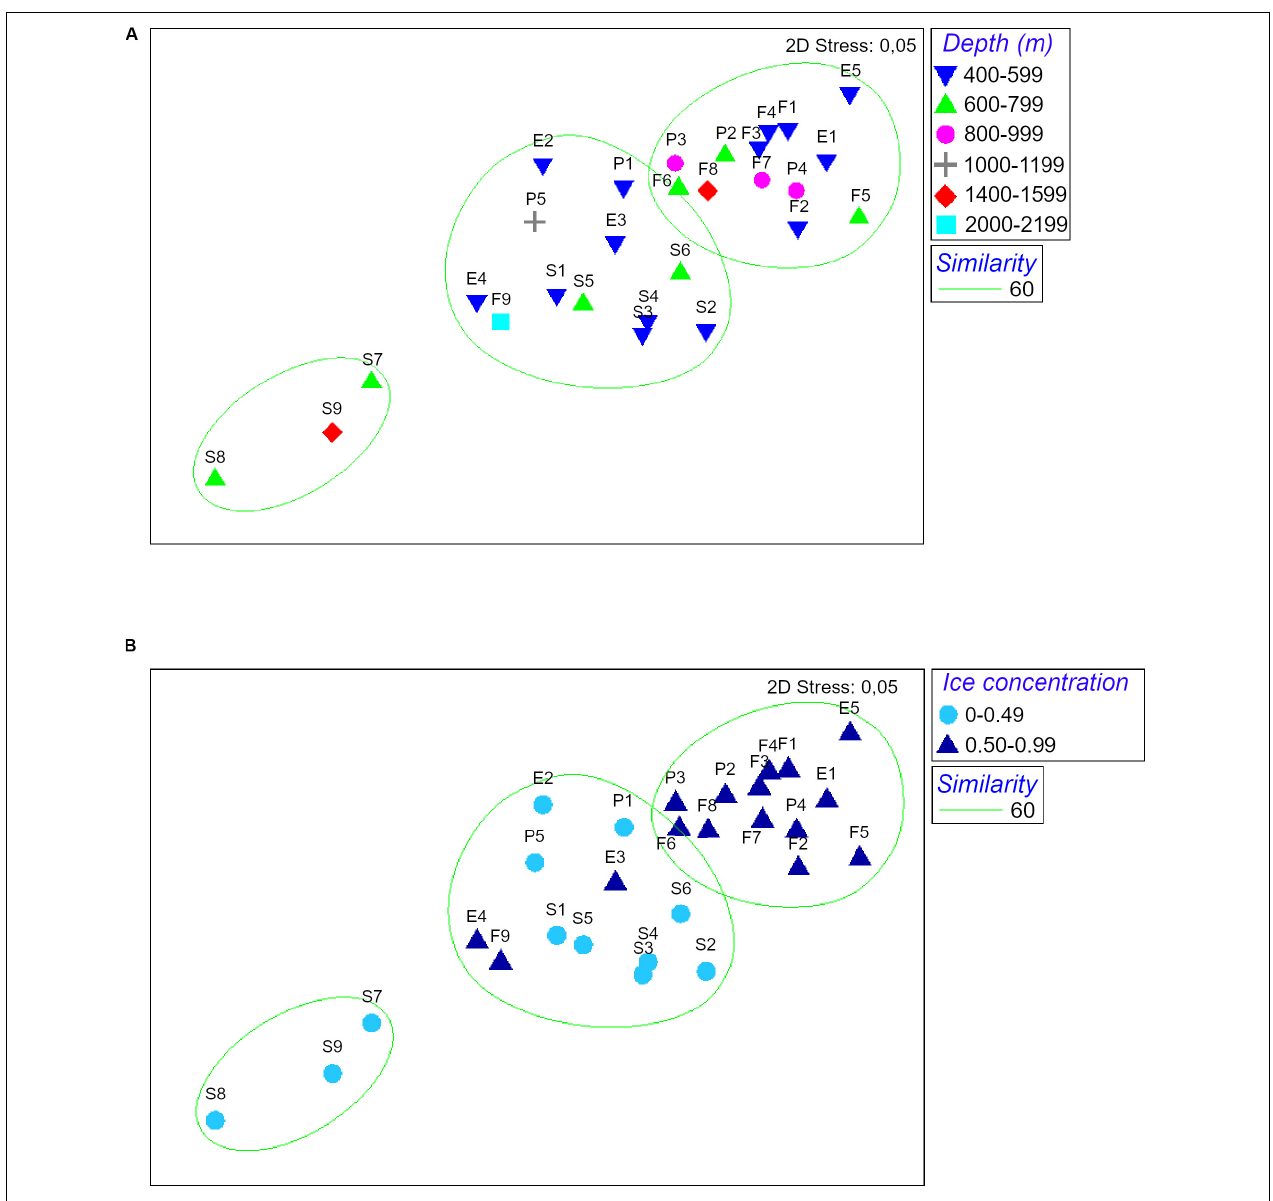
FIGURE 4 | nMDS of ice concentration and depth of peracarid assemblages from all stations. Depth is expressed in meters, ice concentration in fractions from 0 to 1 (where 0 indicates no ice coverage and 1 indicates complete ice